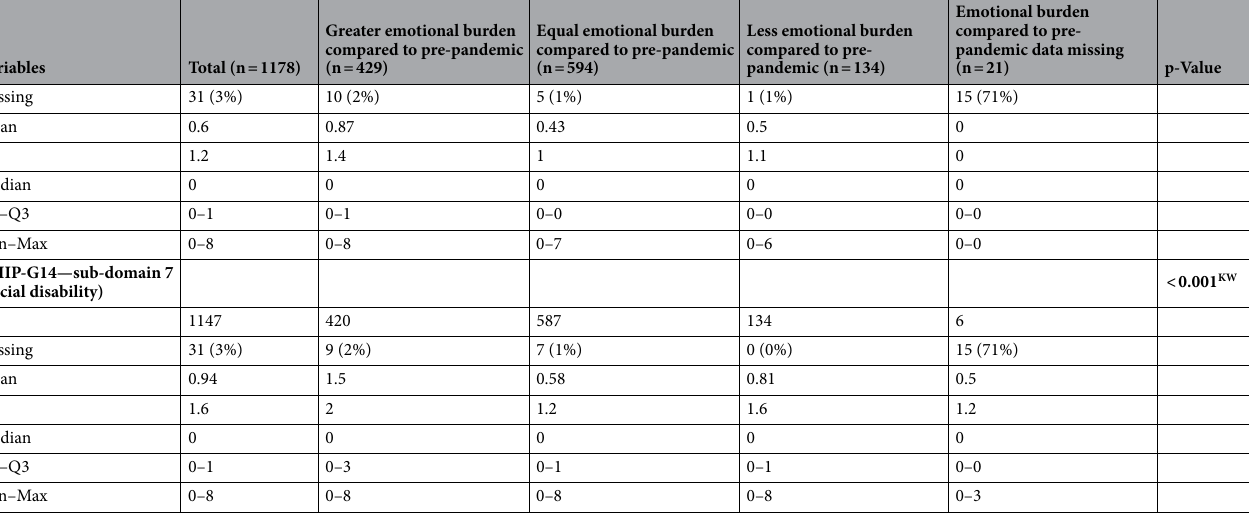
Table 4. Oral health-related quality of life. Significant values are in bold. All missing values were excluded for statistical testing. n number of participants, COVID-19 coronavirus disease 2019, OHIP Oral Health Impact Profile, SD standard deviation, Q Quartile, Min Minimum, Max Maximum, KW Kruskal–Wallis one-way ANOVA.